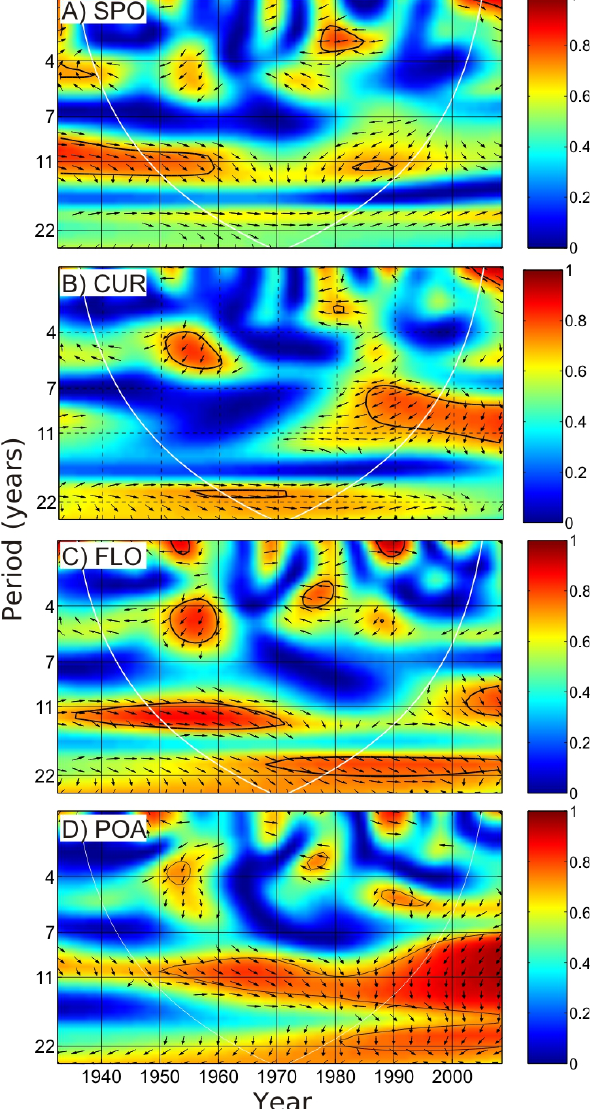
Fig. 6. Similar to Fig. 5, but considered for the wavelet coherence spectrum between the temperature data and the Rz time series com- puted for SPO (A) , CUR (B) , FLO (C) , and POA (D)